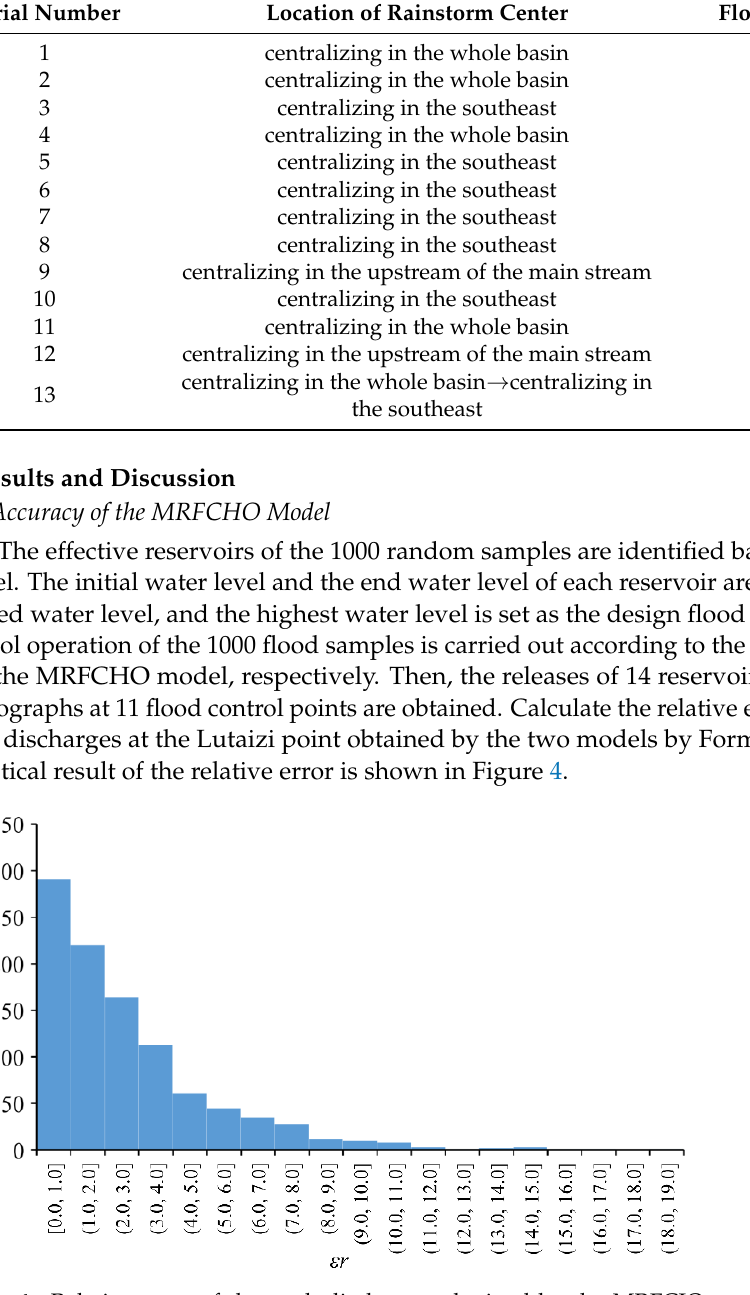
Figure 4. Relative error of the peak discharges obtained by the MRFCJO model and the MRFCHO model.